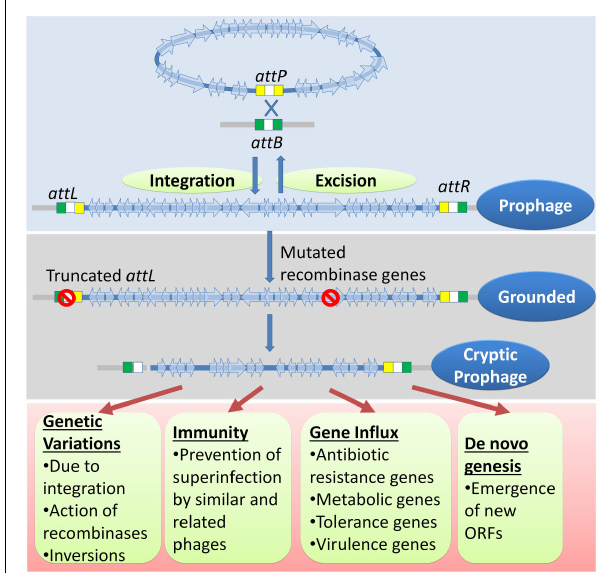
FIGURE 7 | A genetic history and advantages of cryptic prophages. The genome of temperate phages integrates with the bacterial chromosome through site-specific recombination between sites similar to those of attP and attB . Occasionally, mutations in the attL , attR , recombinase genes, and genes encoding other essential accessory factors would result in a ‘grounded’ prophage. Eventually but gradually, more mutations, usually deletions, accumulate to ease the metabolic and genetic burden imposed by the cryptic prophage. The cryptic prophage offers several advantages to the host bacterium. The genetic variations caused in the host genome due to integrations, inversions involving prophage sequences, and the action of their recombinases may have a selective advantage. The prophage confers immunity from secondary phage infection and acts as hotspots for gene influx through horizontal gene transfer of important genes such as those involved in metabolism, antibiotic resistance, virulence, and stress tolerance. More importantly, the cryptic prophage is a site for the emergence of new ORFs that may have novel and useful